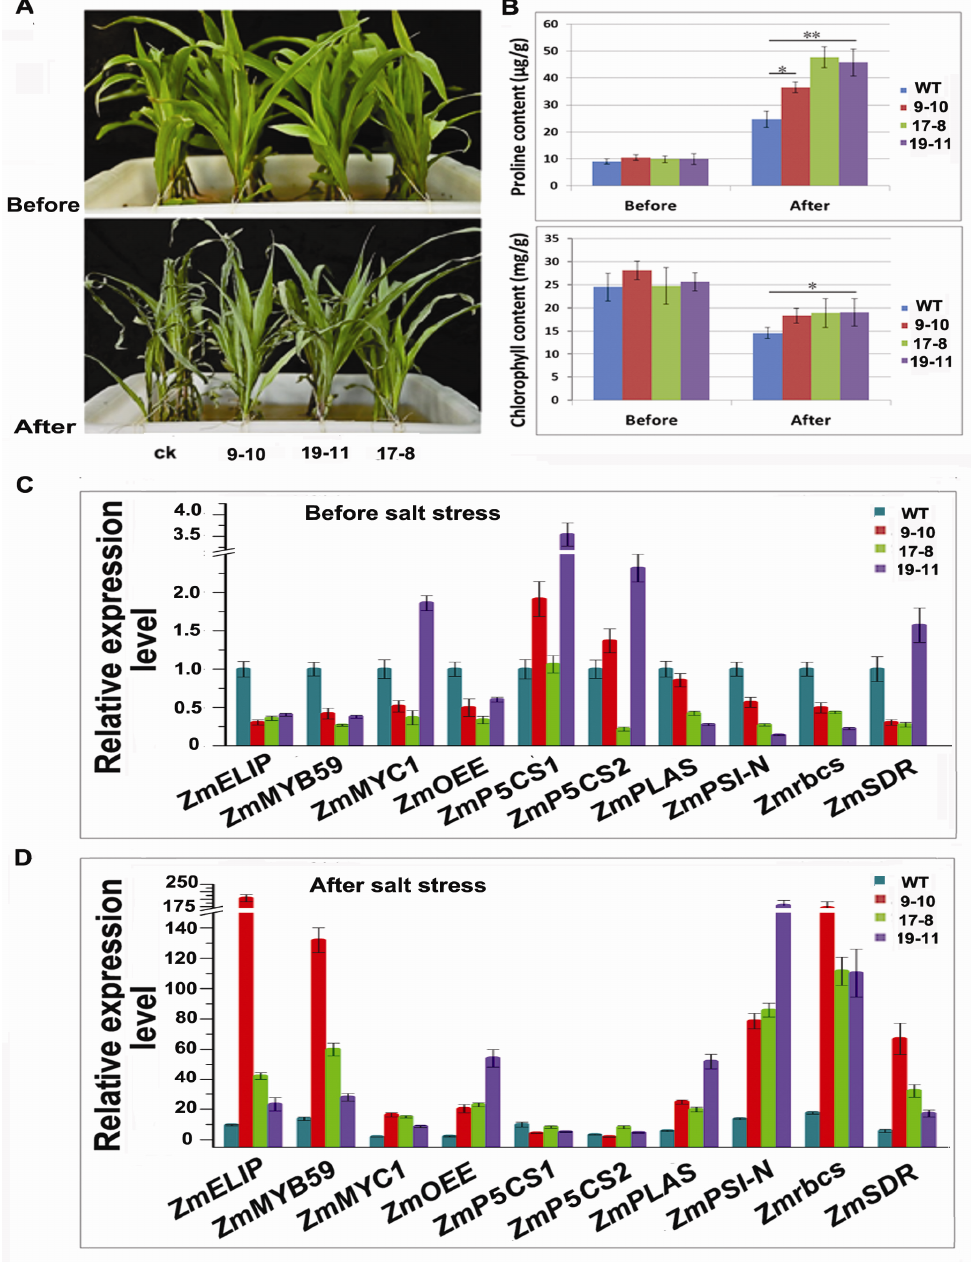
Figure 5. TSRF1 improved salt tolerance in maize. ( A ) Salt tolerance of TSRF1 transgenic maize. Before, control experiment without drought treatment; after, maize seedlings at four-leaf stage were subjected to 200 mM NaCl stress for 48 h; ( B ) proline and chlorophyll content in the control and transgenic maize. Data are averages of triplicate ± standard deviations. Asterisks, * and **, denote statistically different from wild-type by Student t -test at p < 0.05 and p < 0.01, respectively; ( C ) relative expression of stress-related genes in wild-type and TSRF1 transgenic maize seedlings before salt treatment; ( D ) relative expression of stress-related genes in wild-type and TSRF1 transgenic maize seedlings after salt treatment. Total RNA extracted from leaves of maize seedlings before and after 200 mM NaCl treatment for 48 h was used, respectively. Tubulin was used as a reference gene. Data are averages of triplicate ± standard